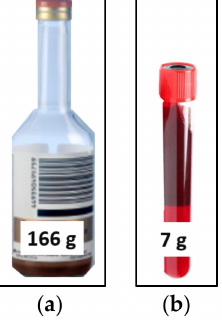
Figure 5. ( a ) Bottle weighting 166 g and having a volume of 50 mL; ( b ) Tube weighing 7 g and having a volume of 10